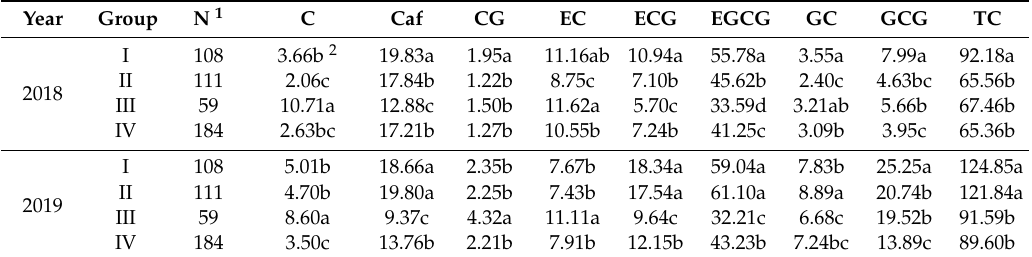
Table 2. Average cluster values of the phytochemicals in the 462 tea accessions for the two years (mg /